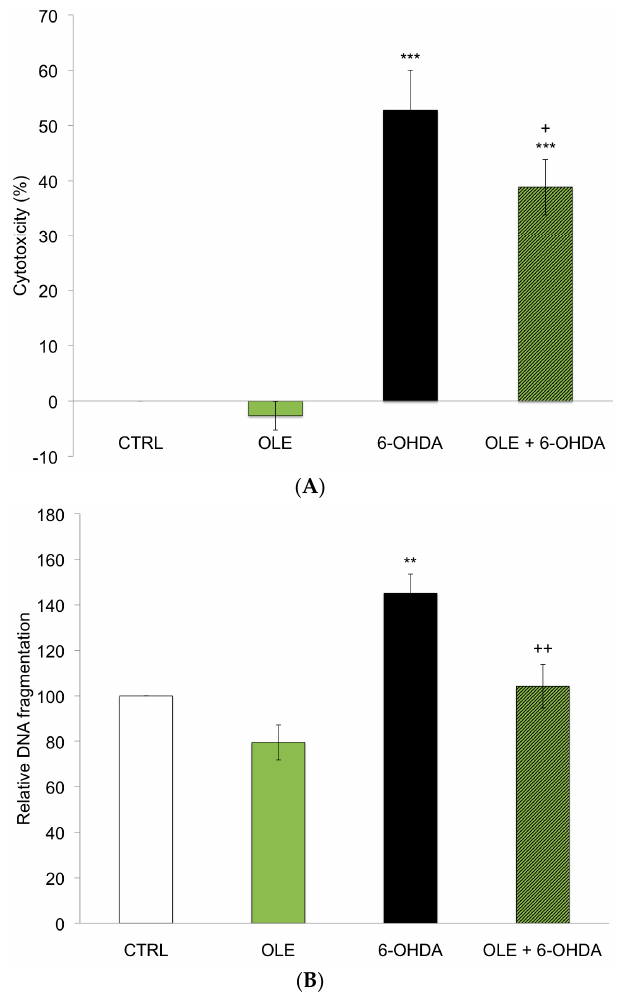
Figure 1. Oleuropein (OLE) prevents 6-hydroxydopamine (6-OHDA)-induced neuronal death. ( A ) Effect of OLE on 6-OHDA-induced toxicity was evaluated by measuring lactate dehydrogenase (LDH) activity in supernatants of damaged cells. Neuronal PC12 cells were pre-treated with or without 10 − 12 M OLE for 3 h, then 40 µM 6-OHDA were added for 24 h. Pre-treatment with OLE partially prevented neuronal PC12 cell death induced by 6-OHDA. Values are the average of six samples from three independent experiments for a total of 18 measurements. Data are expressed as means ± SEM (standard error of the mean). *** p ˂ 0.001 compared to control condition (CTRL) and + p ˂ 0.05 compared to 6-OHDA; ( B ) Levels of apoptotic cells were assessed by detecting apoptosis-specific DNA denaturation by formamide using a monoclonal antibody against single-stranded DNA. Neuronal PC12 cells treated with 40 µM 6-OHDA alone show a significant increase in apoptosis compared to CTRL. Administration of 10 − 12 M OLE 3 h prior to 6-OHDA treatment promotes a decrease in DNA denaturation. Values are the average of six samples from three independent experiments for a total of 18 measurements. Data are expressed as means ± SEM. ** p ˂ 0.01 compared to CTRL and ++ p ˂ 0.01 compared to 6-OHDA.